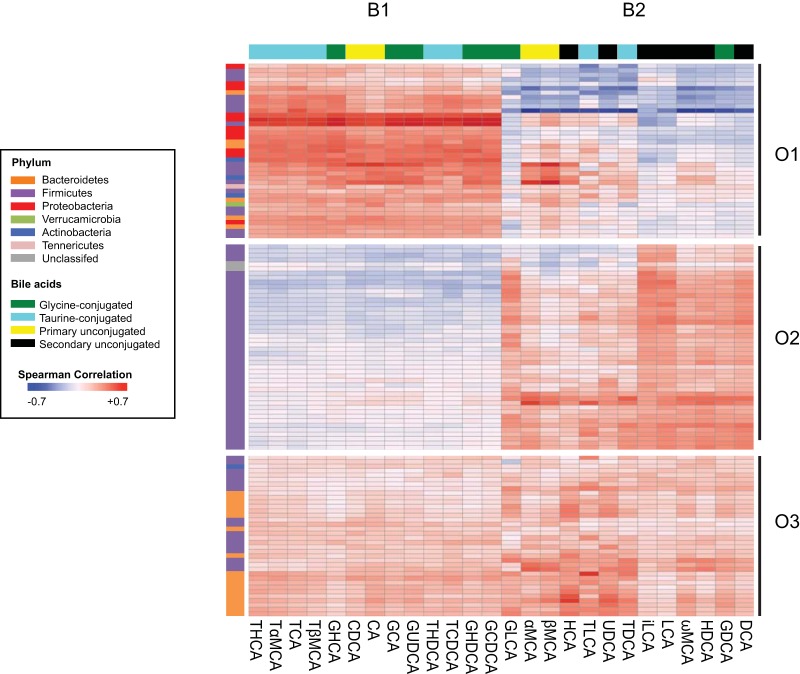
Correlation analysis of the gut microbiome and bile acids. Spearman’s correlation analysis was done with all 121 OTU (i.e., OTU that were greater than 1% of the total bacterial population) in the microbiome, color coded by phylum and grouped based on unsupervised clustering. All 26 bile acids detected were similarly clustered and are color coded based on structure. There were three distinct clusters of OTU (O1 to O3) and two distinct clusters of bile acids (B1 and B2). The heat map scale ranges from positively correlated, +0.7, to negatively correlated, −0.7.